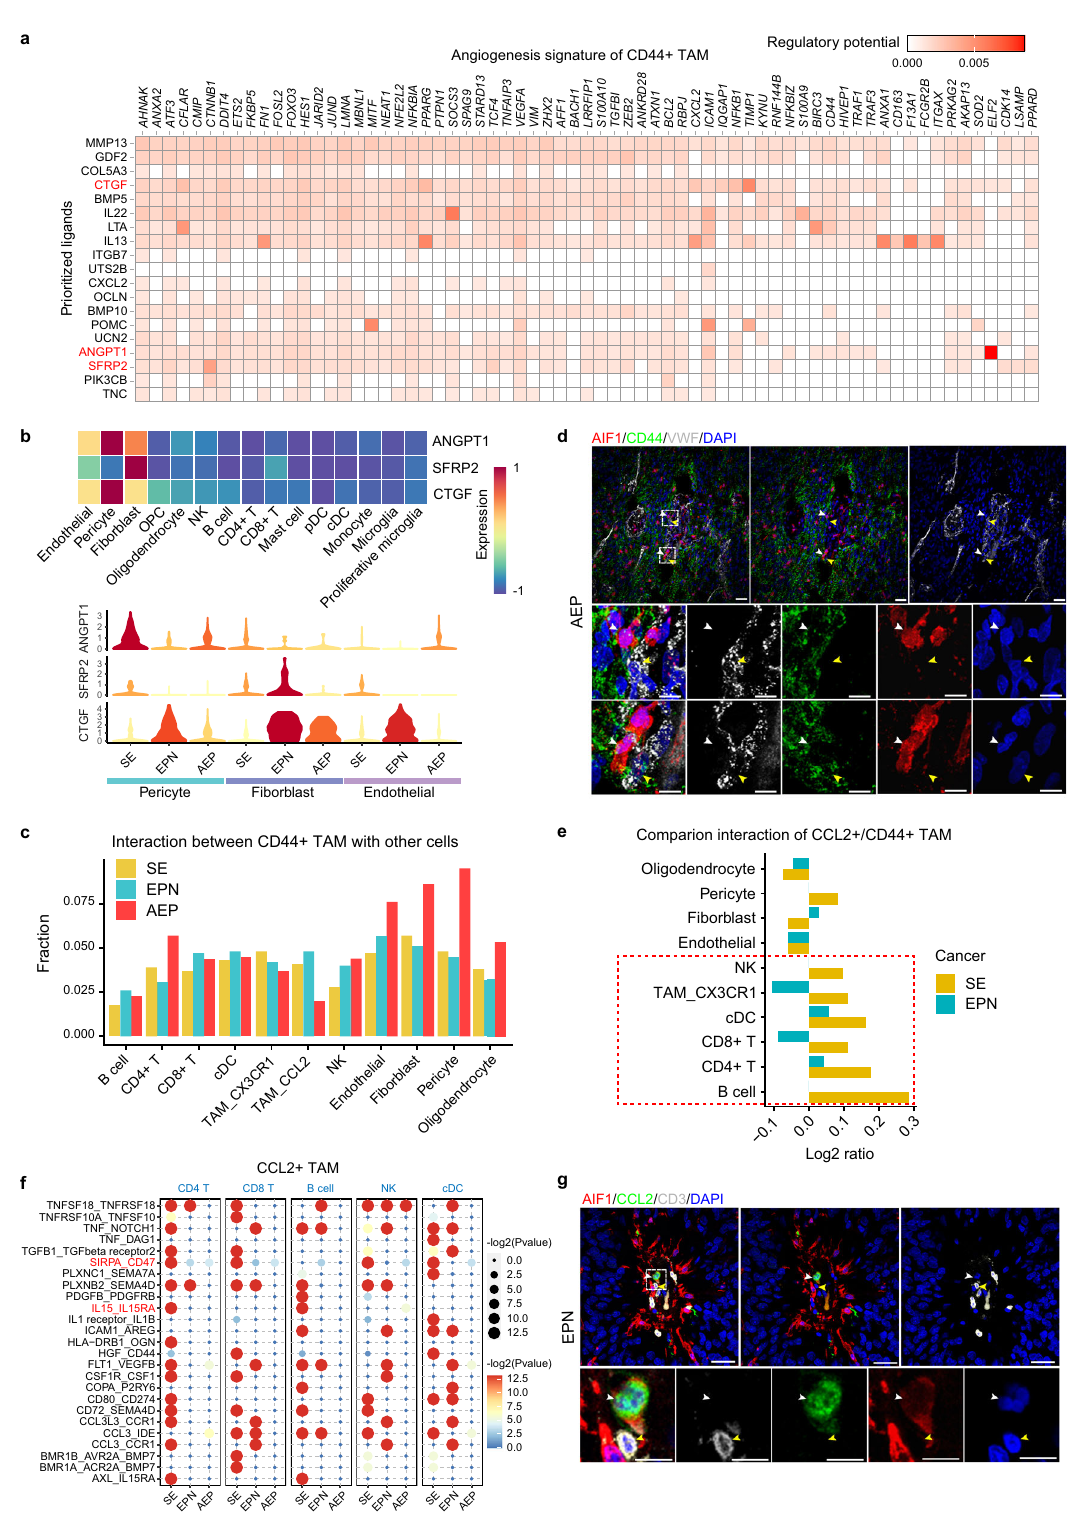
(Sigma, Cat #NUC-101) and incubated on ice for 5min. Then nuclei were centrifuged at 500× g for 5 min at 4°C. Repeat the wash and centrifuge step again. After that, nuclei were resuspended with PBS, and Debris Removal Solution (MACS) was added to effectively remove cell debris. Isolated nuclei were suspended in Nuclei Suspension Buffer (NSB; consisting of 1× PBS, 0.01% BSA and 0.1% RNase inhibitor (Clontech, Cat #2313A)). A fi nal nuclei suspension was fi ltered through a 35- μ m cell strainer (Corning, Cat #352235) and used for single-cell libraries preparation.